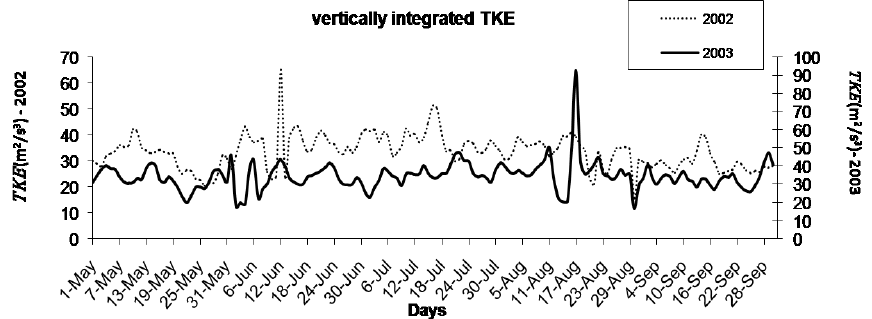
Fig. 6. Variation of Vertically Integrated (1000–100hPa) total kinetic energy from 1 May–30 September during 2002 and 2003. Fig (6): Variation of Vertically Integrated (1000-100hPa) Total Kinetic energy from 1 May - 30September during 2002 & 2003.